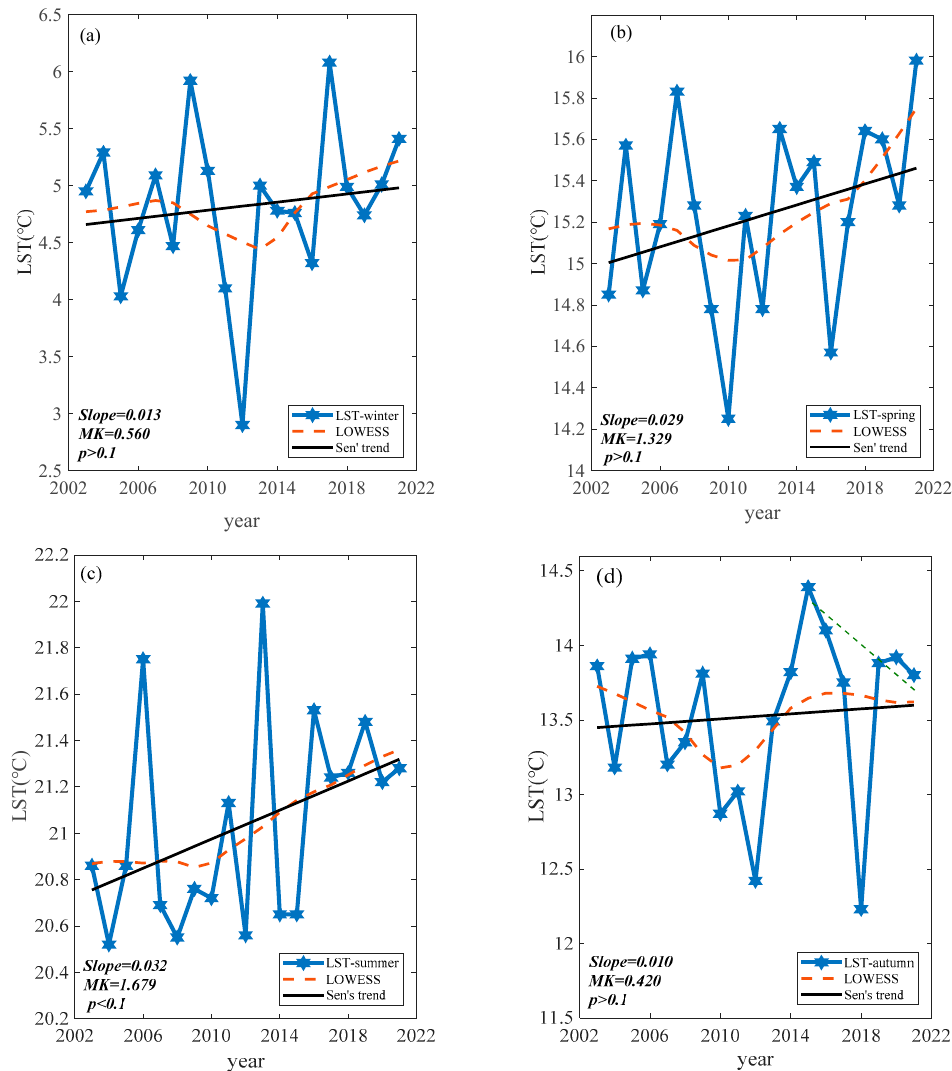
Figure 4. Average LST change trends from 2003 to 2021: ( a ) winter; ( b ) spring; ( c ) summer; ( d ) autumn. The green line is a piecewise linear fitting.